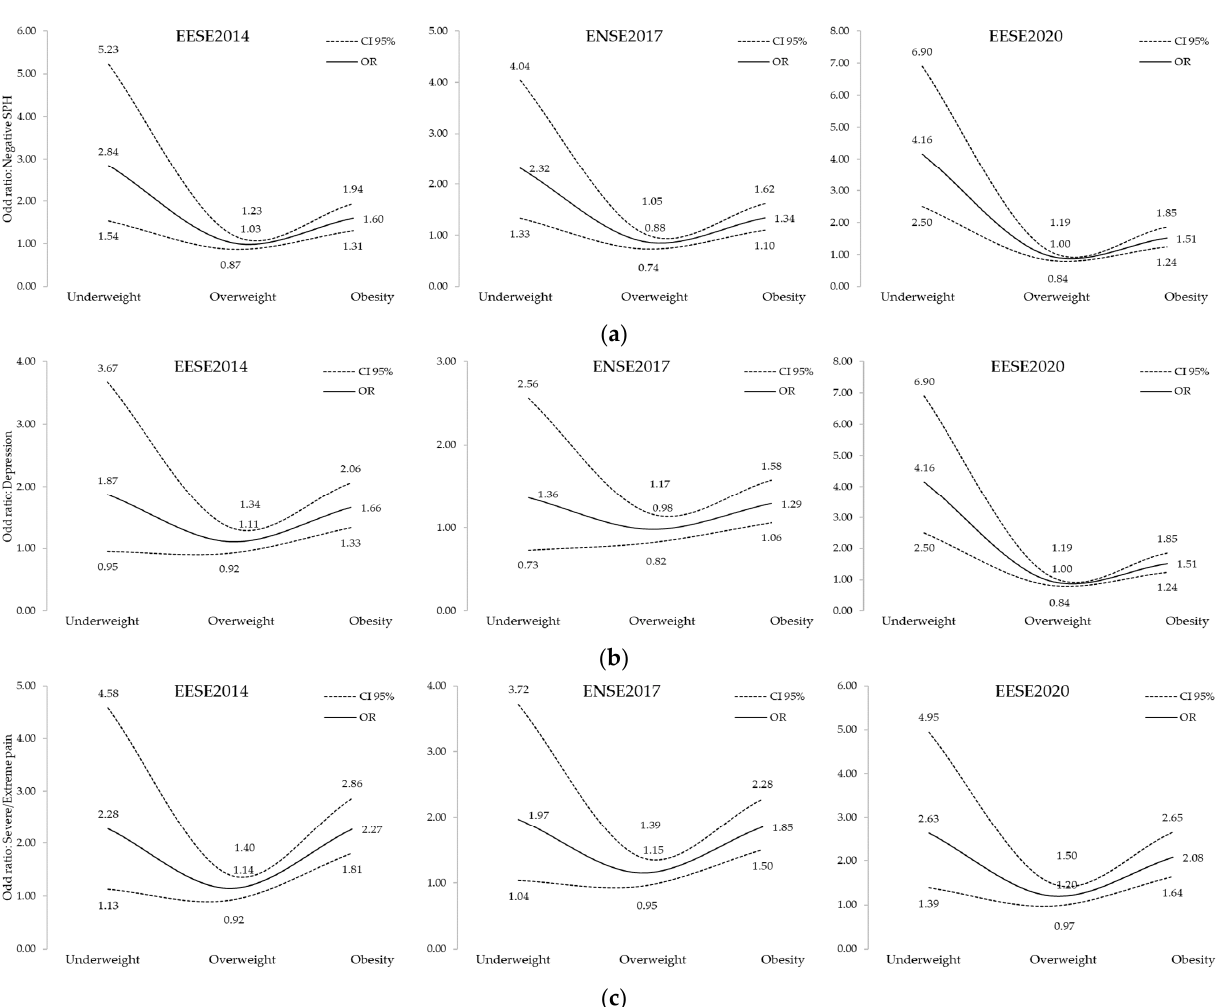
Figure 6. ( a ) Odds ratio for Negative Self-Perceived Health; ( b ) Odds ratio for Depression; ( c ) Se- vere/Extreme Pain Degree according to the Body Mass Index in the Spanish population in the three surveys EESE2014, ENSE2017, and EESE2020.